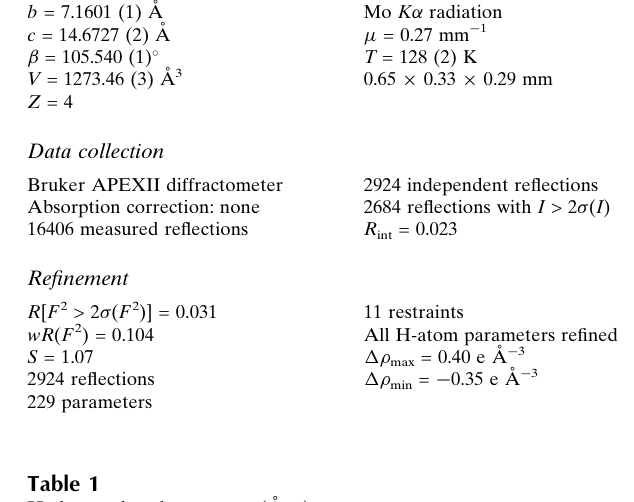
Hydrogen-bond geometry (A˚ , (cid:1)